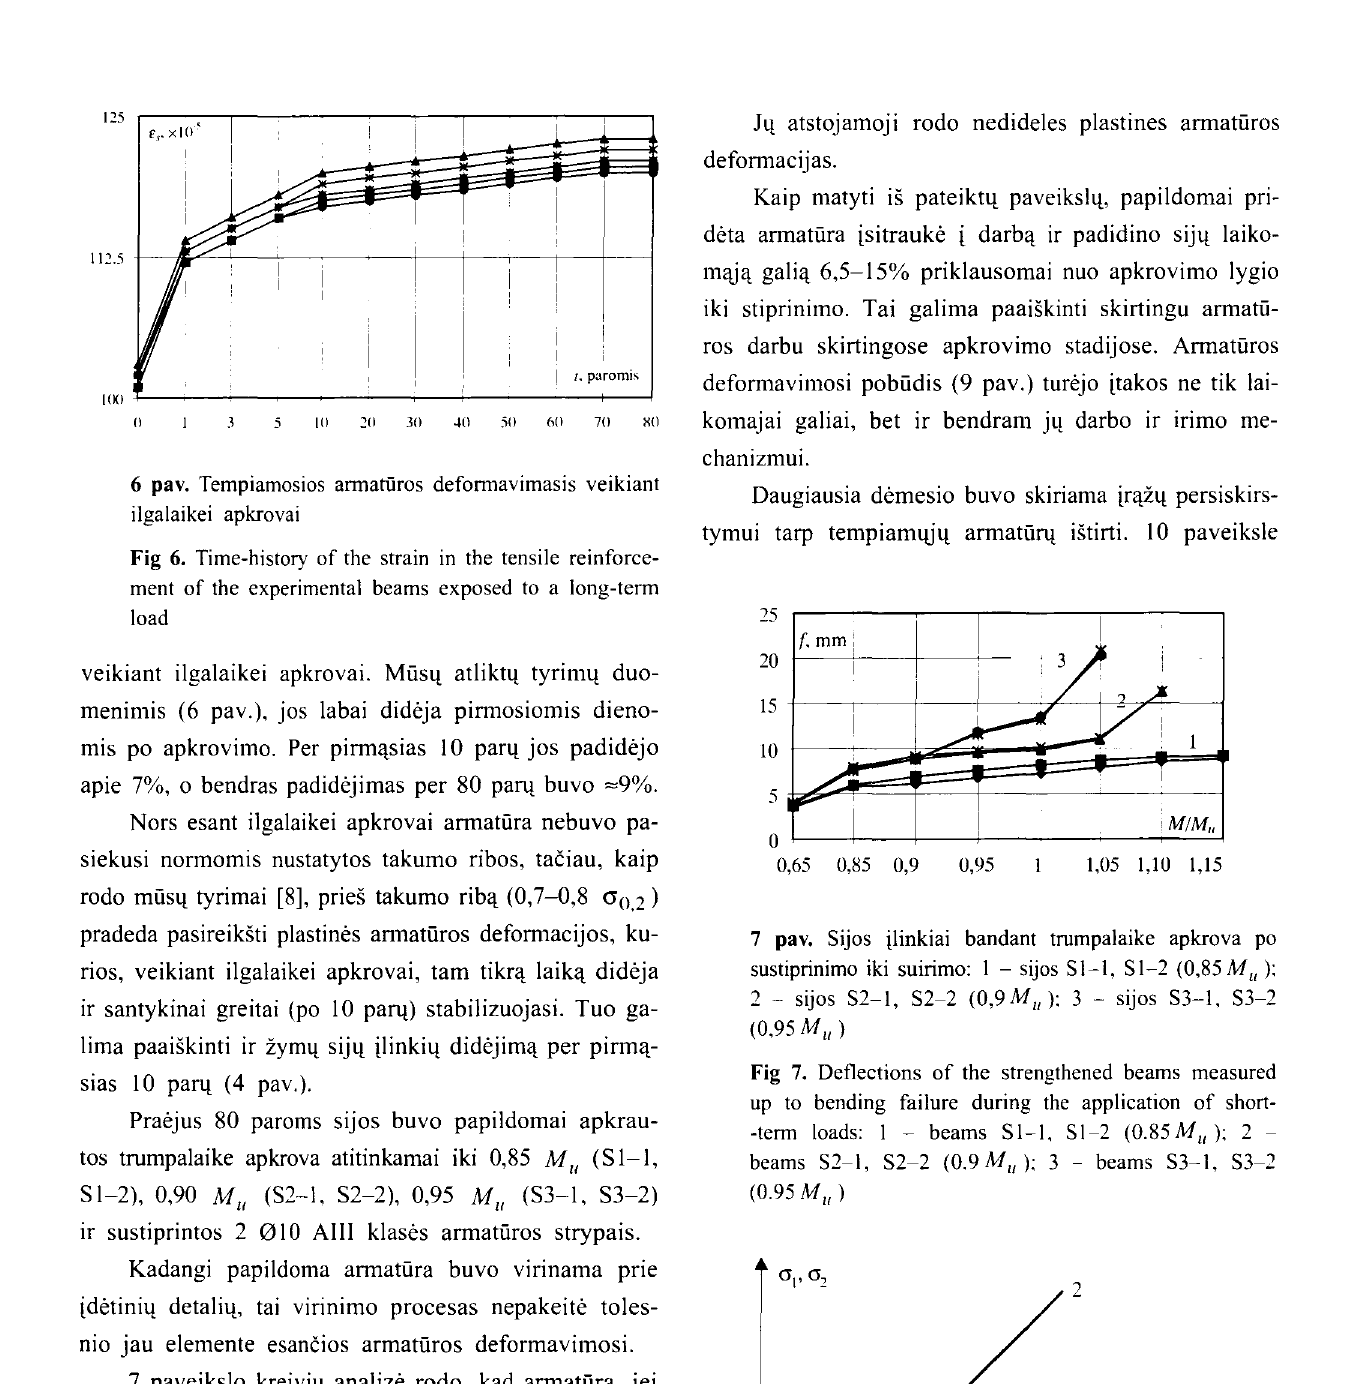
1 1.! atstojamoj i rodo nedideles plastines armaturos deformacijas.